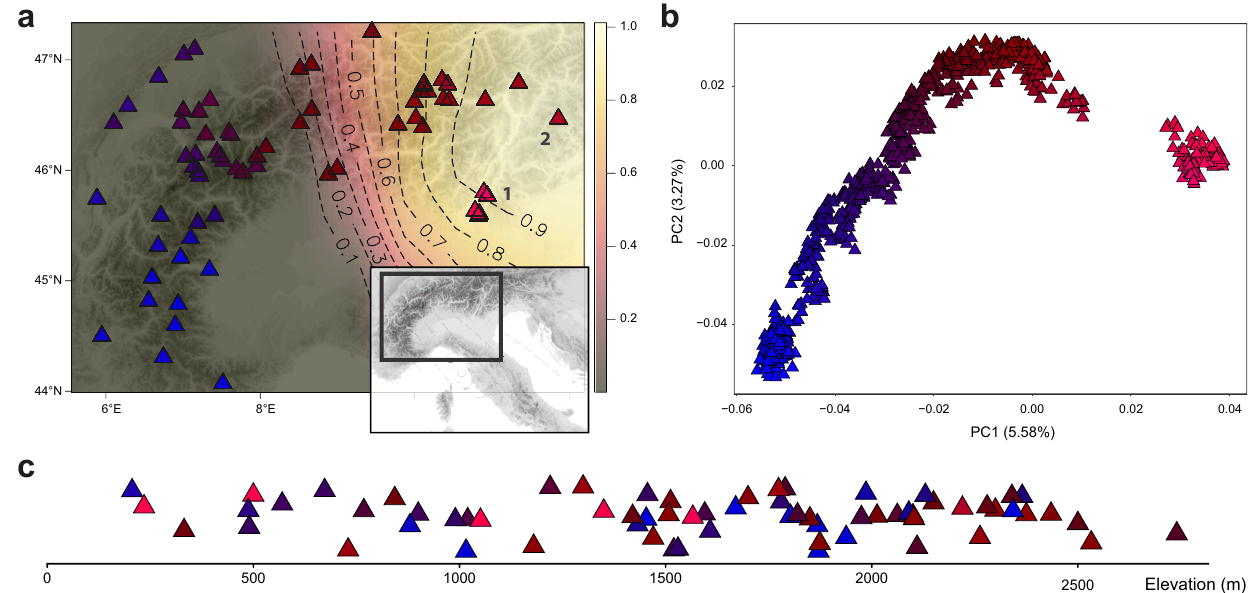
Fig. 3 | Genes mirror geography in the Alps. A Geographic sampling of Alpine populations. Black dashed contours and colour gradient re fl ect the probabilistic inference of the origin of the Alpine expansion, calculated via a time difference of arrival (TDOA) algorithm on the directionality index ψ . An eastern origin for the AlpinelineagearoundtheregionsofMonteBaldo(1)andthewesternDolomites(2) is inferred. B Genetic structure of Alpine individuals inferred via principal